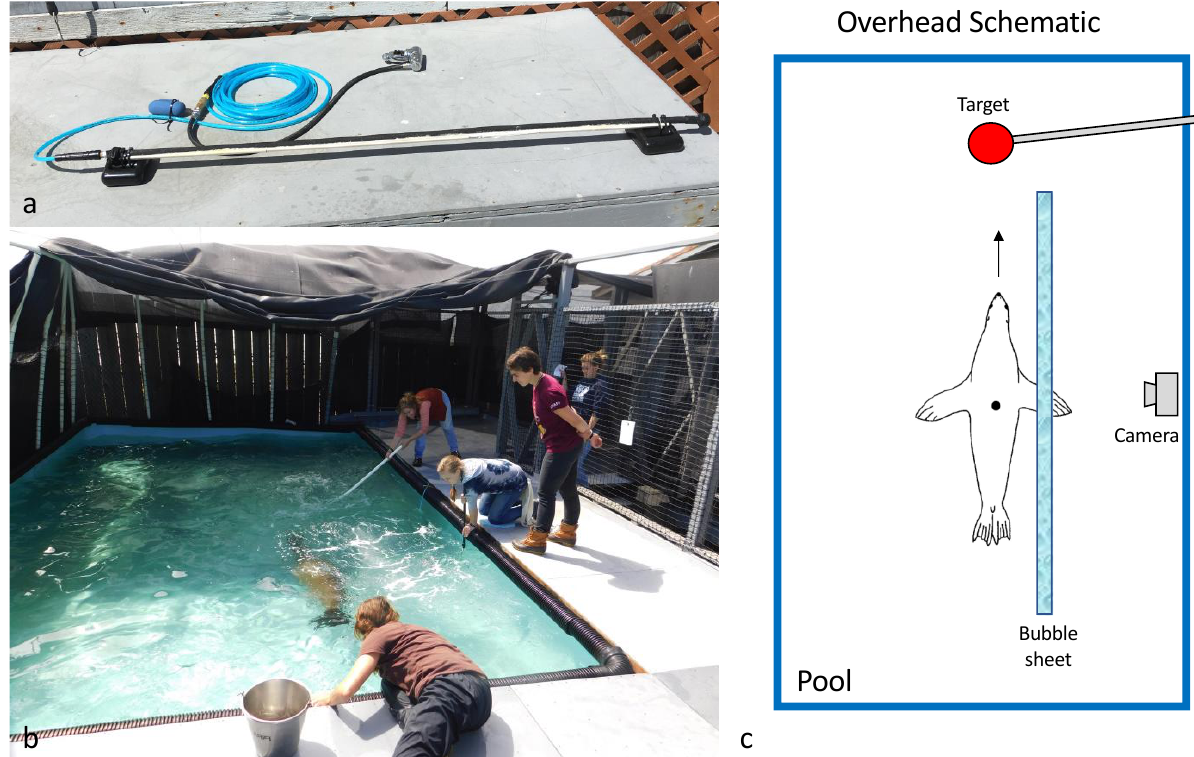
Figure 2. The top-left panel ( a ) shows the perforated hose used to generate a sheet of seeding bubbles. The bottom-left panel ( b ) is the pool used for data collection. The image includes SLEWTHS and research team members as well as Cali, the California sea lion that generated the present data. The left panel ( c ) is an overhead schematic of the experimental setup. The sea lion’s swimming direction and locations of the bubble sheet and camera are shown.